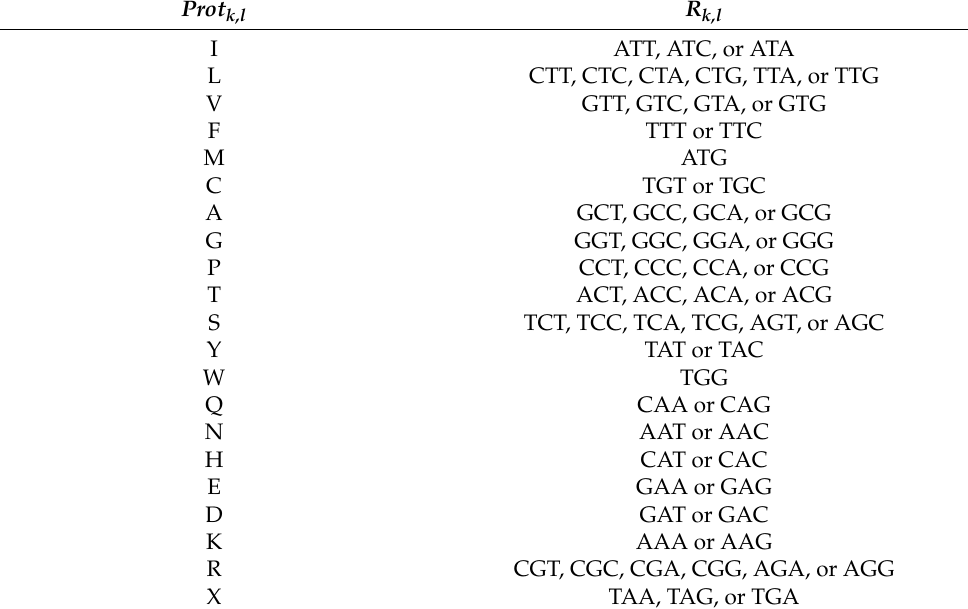
Table 3. Translation